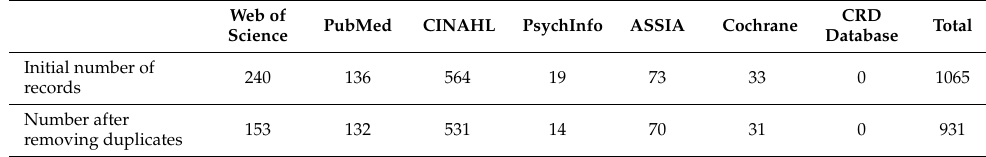
Table A3. Number of records identified in each